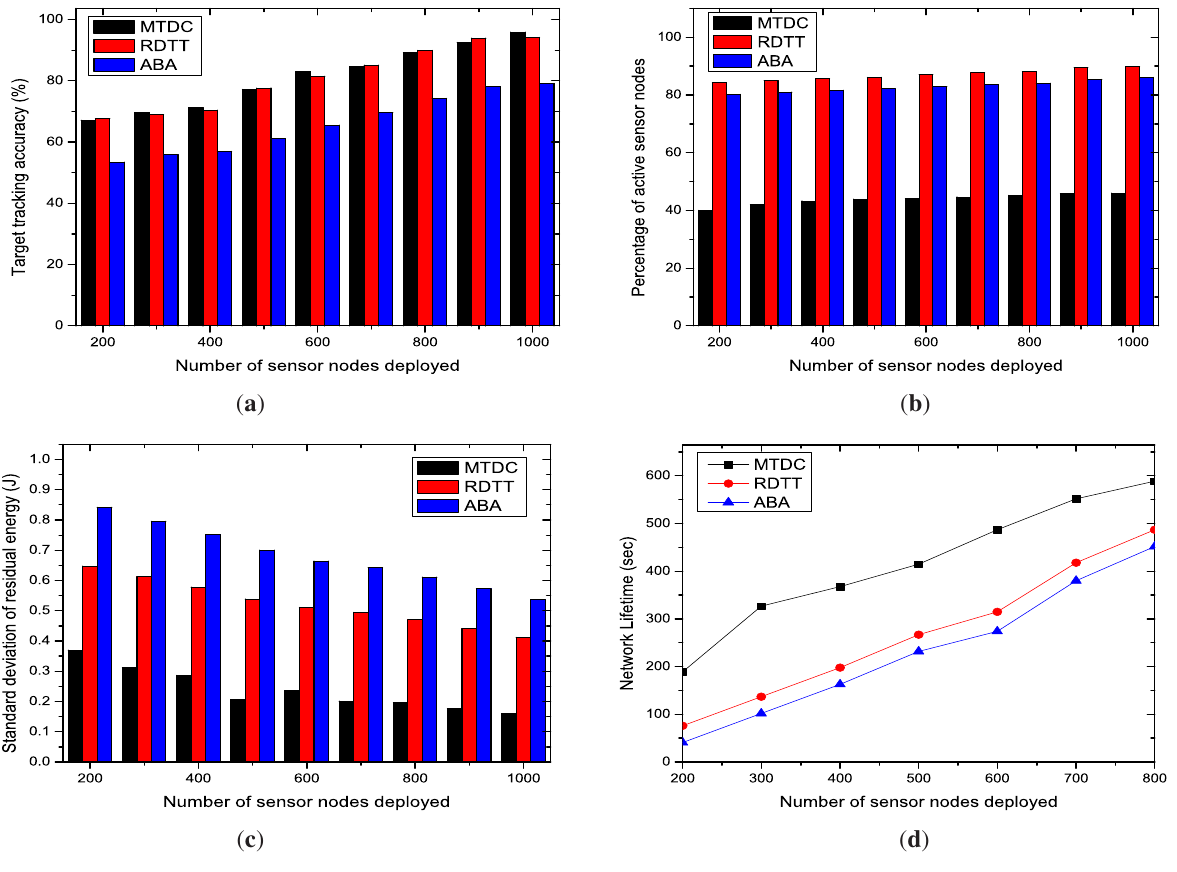
Impacts of the number of sensor nodes. ( a ) Target tracking accuracy; ( b ) percentage of active sensing nodes; ( c ) standard deviation of residual energy; ( d ) network